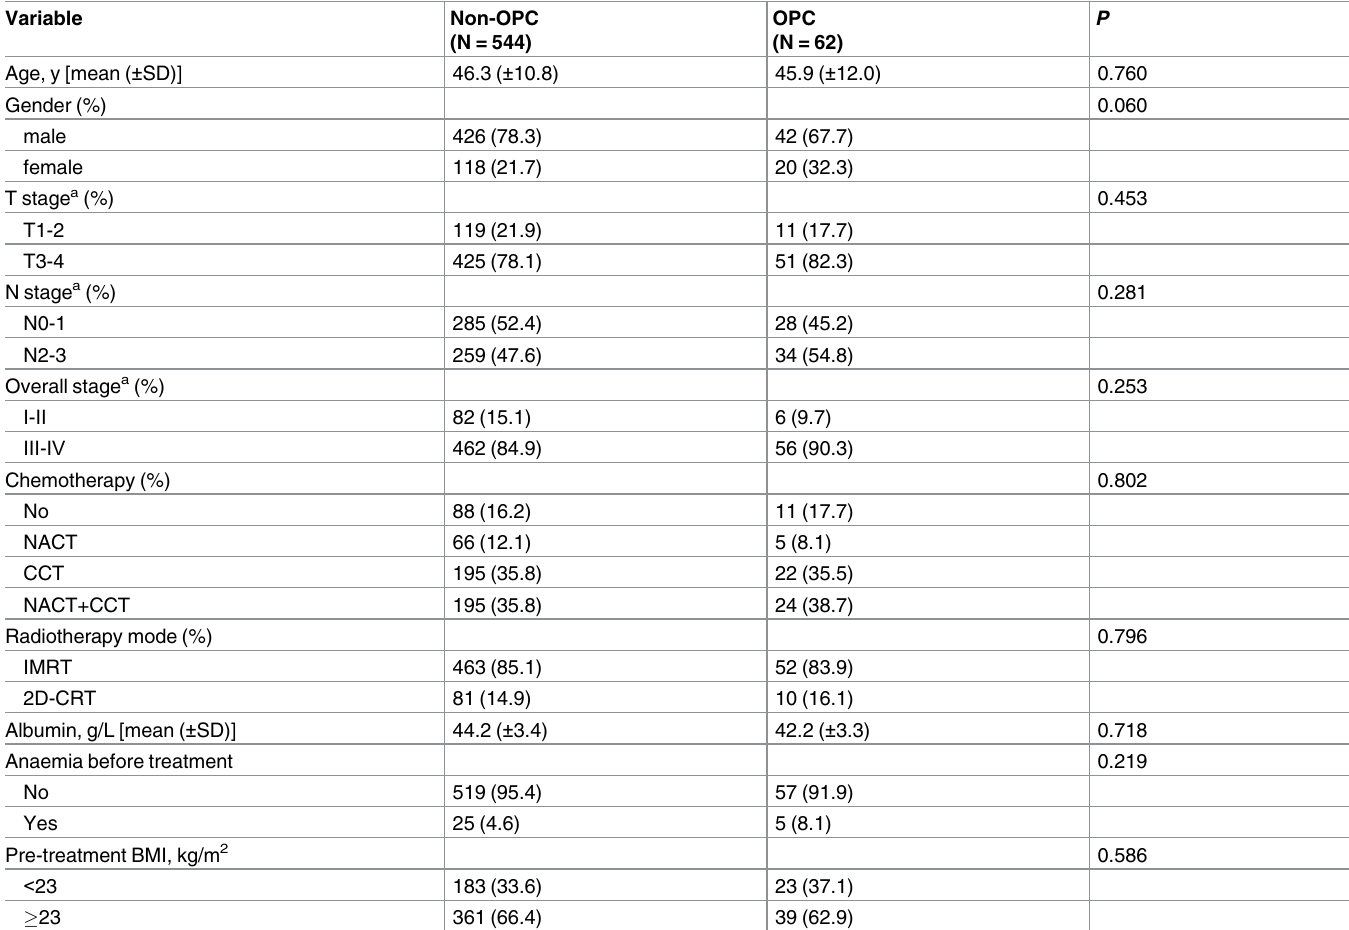
Table 1. Clinical data of 606 nasopharyngeal carcinoma